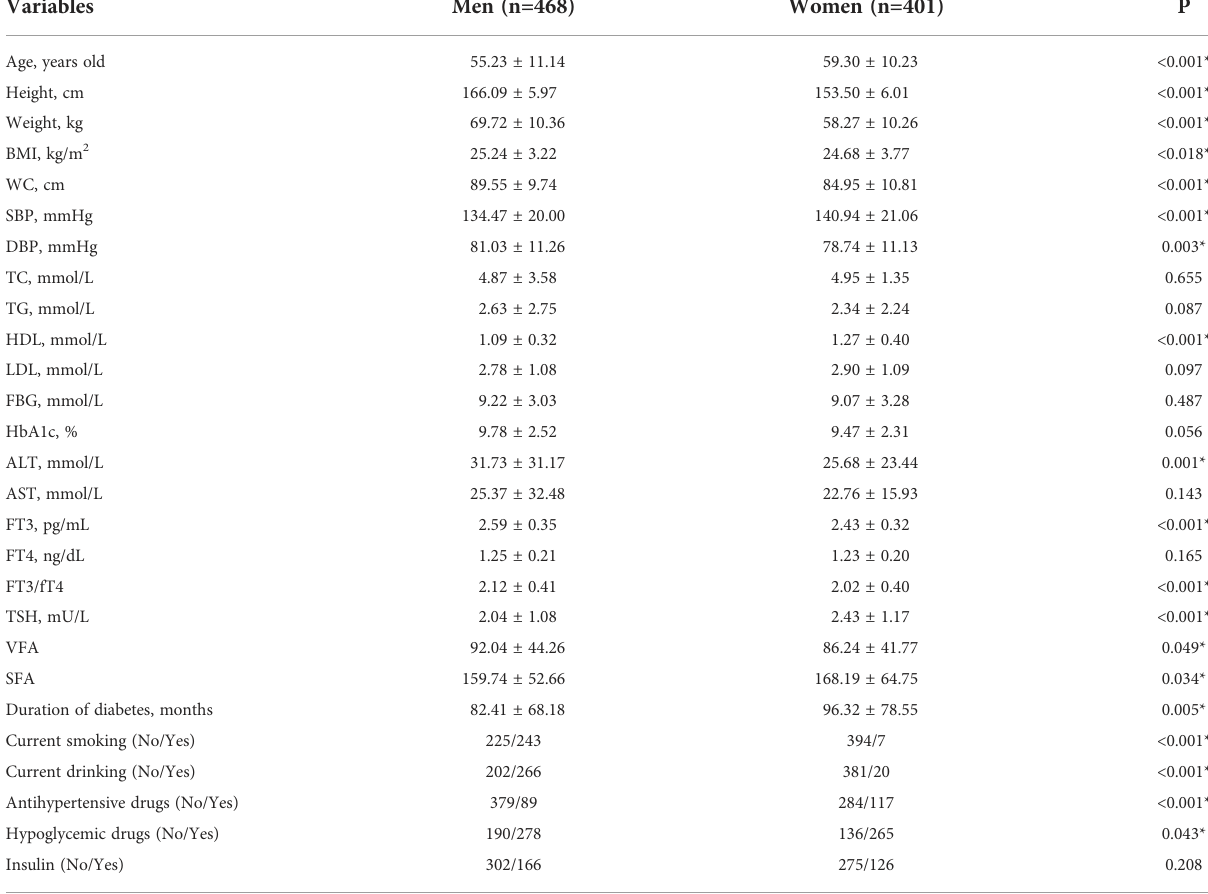
TABLE 1 Clinical characteristics according to